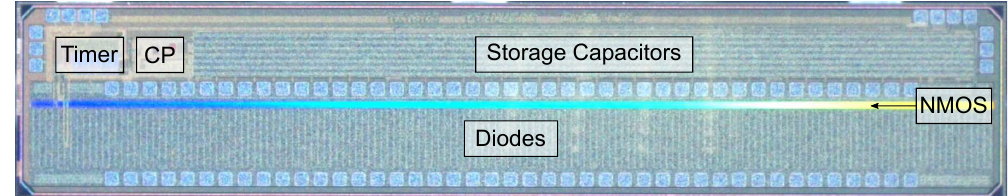
Figure 14. Photo of the NIMBUS chip in the I3T50 technology from OnSemi.